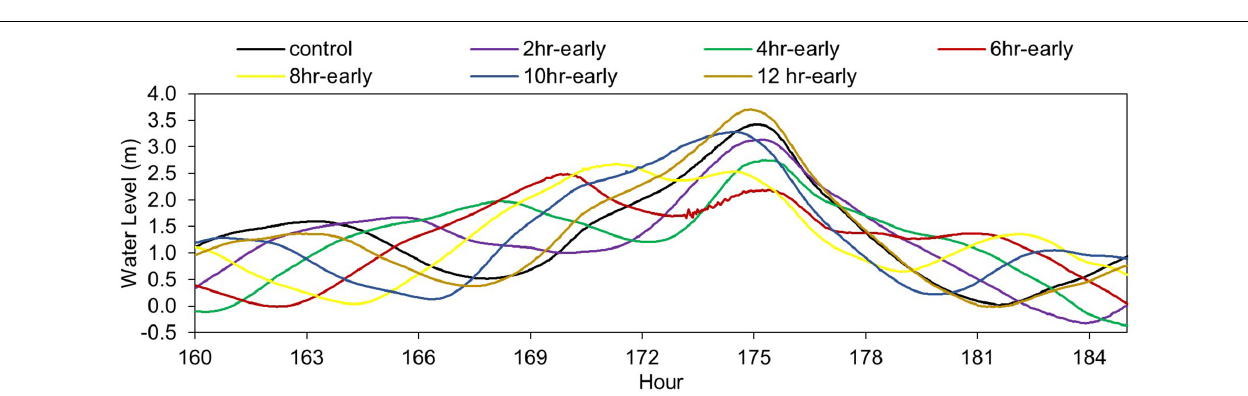
FIGURE 8 | Simulated time series of the storm tide at The Battery based on the control run and numerical experiments. Horizontal axis is the simulation time from October 22, 1800